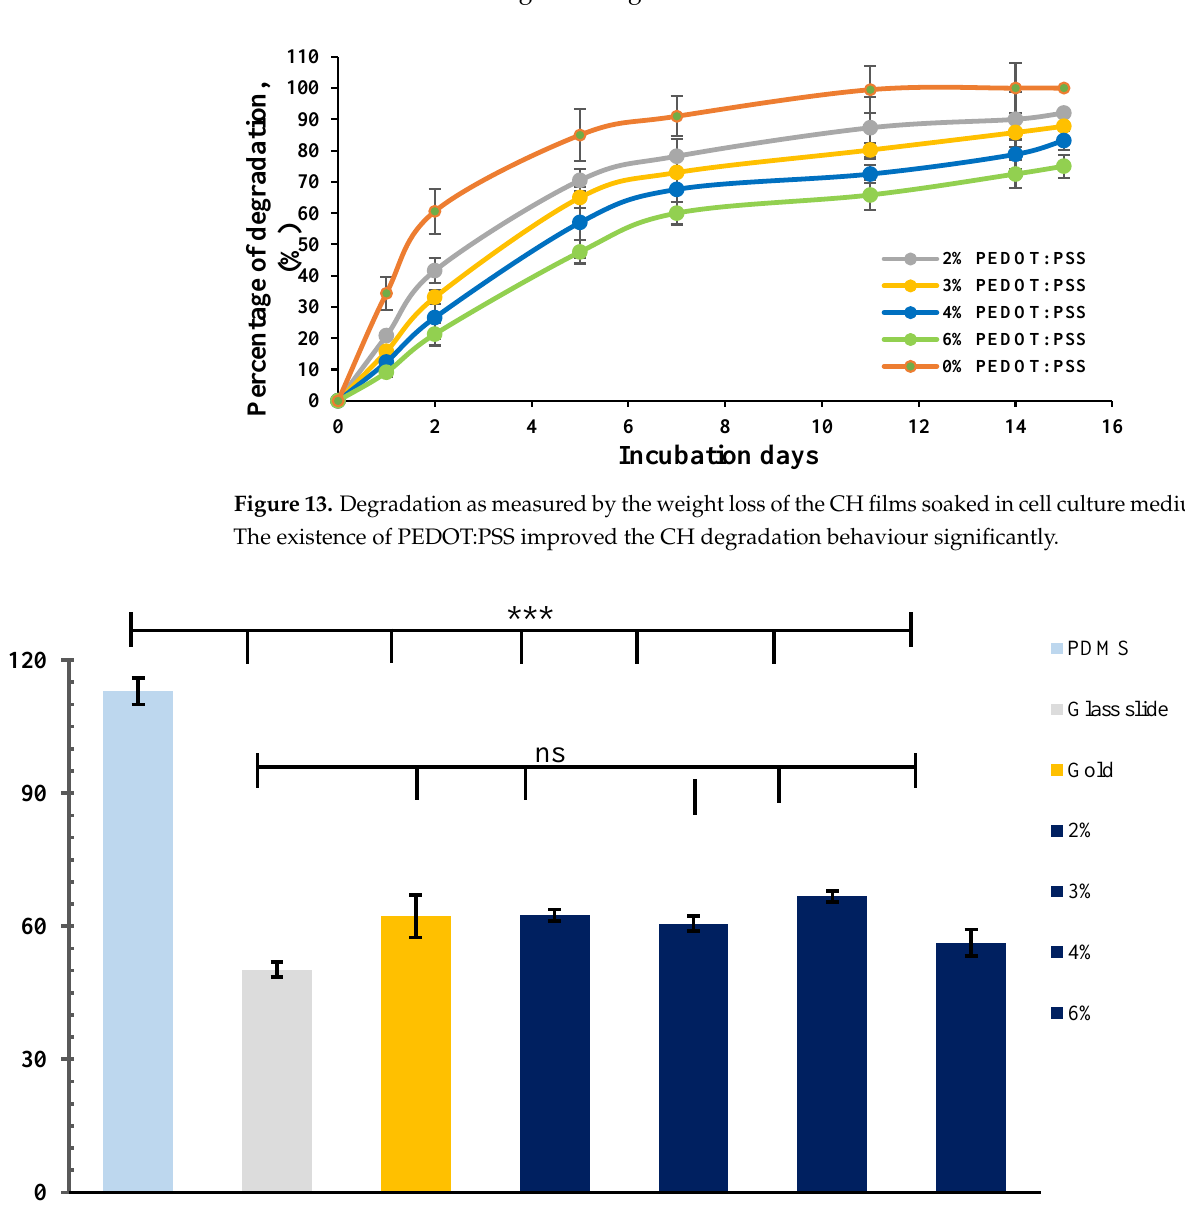
Figure 14. The graph indicates that the CH surfaces have suitable wettability with an average contact angle ranging be- tween 56.2 ± 3.0° to 66.7 ± 1.2°. Denotes *** p < 0.0001; ns = not significant with p > 0.05; n = 5.